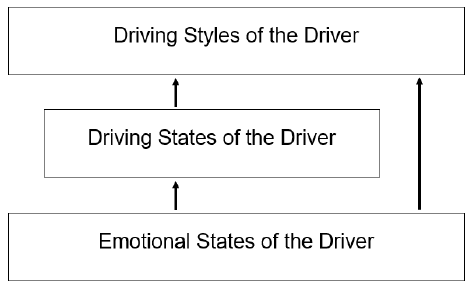
Figure 1. Hierarchical pattern of driving styles.